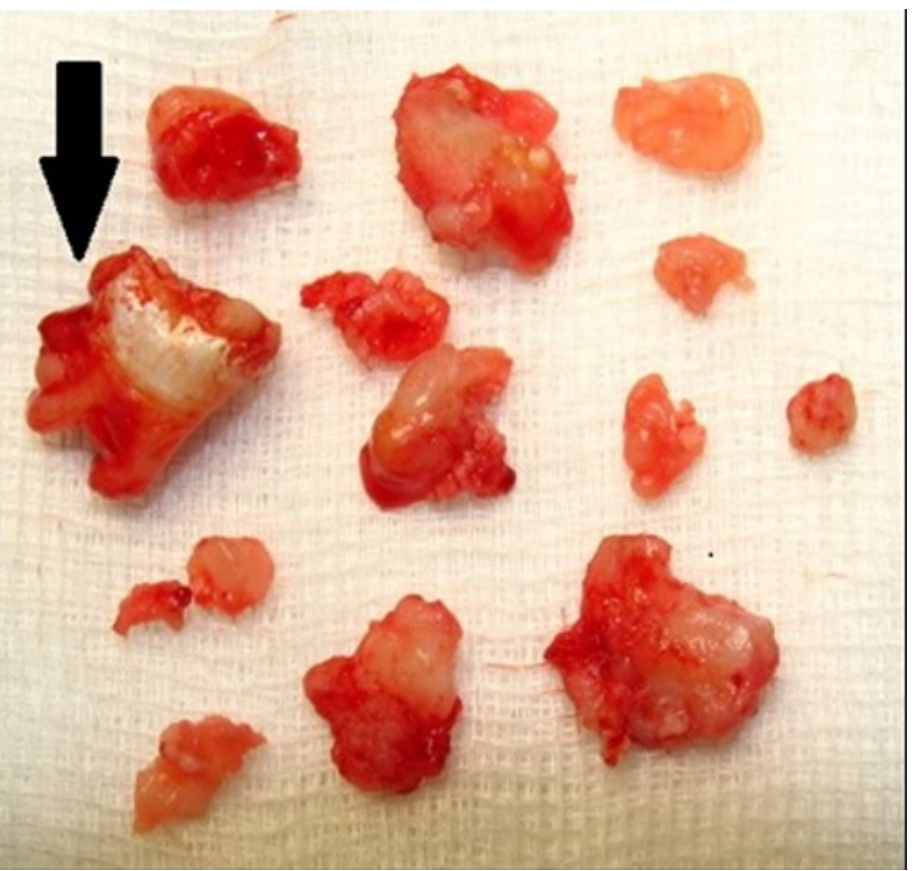
Figure 6. Specimen–removed calcified bodies of varying shapes and sizes compatible with odontogenic tissue and the unerupted tooth 47 (black arrow). Courtesy of Dr. W. Pawlak.